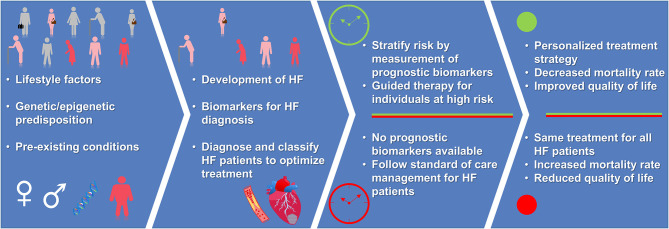
Advantage of having a prognostic biomarker for personalized treatment strategy. Presence of prognosis biomarkers allows for early identification of individuals at-risk of developing HF. For individuals with HF, measurement of prognosis biomarkers guide the treatment strategy leading to reduced risk of mortality and improved quality of life (green color), when compared to absence of prognosis biomarkers and standard of care management (red color). Depiction of human figures: pink, humans at-risk of HF; red, humans having HF; gray, healthy humans.